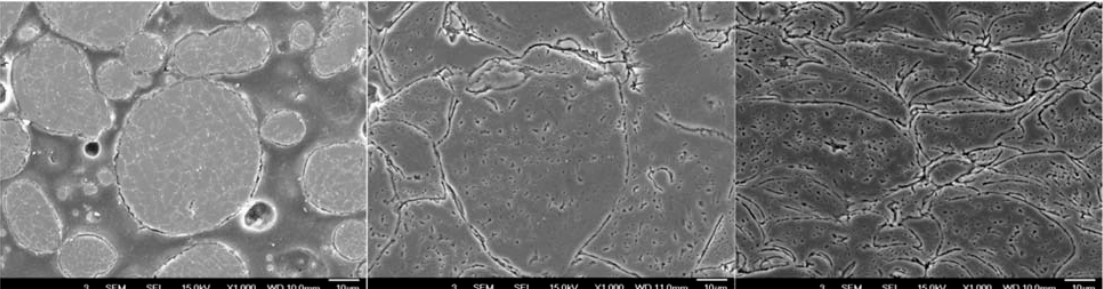
Figure 40. SEM micrographs ( Left ) Al 6061 powder, ( Middle ) orthogonally orientated, relative to the spray direction, Al 6061 cold spray consolidation, and ( Right ) cross-sectionally oriented Al 6061 cold sprayed material. Each of the samples were etched with 0.5% HF solution for 90 s. Scale bars read 10 µ m. The average aspect ratio of the particles and grains within the Al 6061 powder prior to deposition was 1.09 and 1.41, respectively. The cold sprayed Al 6061 coating oriented orthogonally to the spray direction-maintained aspect ratios of 1.44 and 1.40, respectively. Finally, the Al 6061 consolidation orientated cross-sectionally maintained aspect ratios of 2.22 and 2.77, respectively.